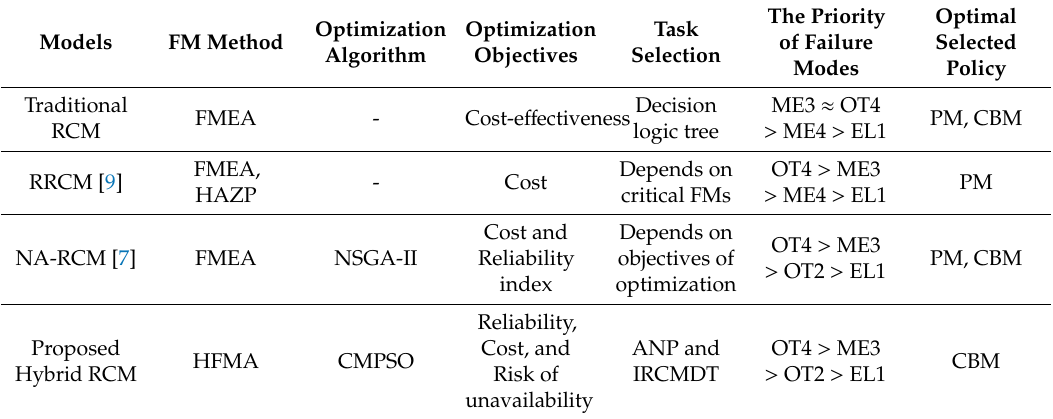
Table 8. Comparison between the proposed model and other recent RCM